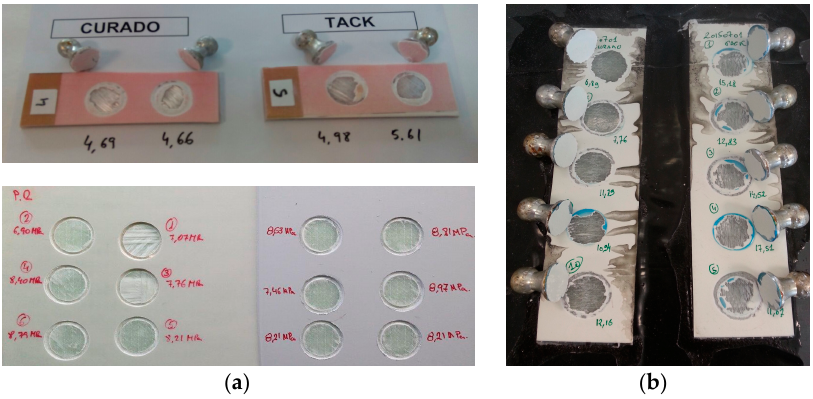
Figure 16. ( a ) Pull-off strength testing of composite laminates used for coating adhesion. Images of the failure in the laminate ( b ).